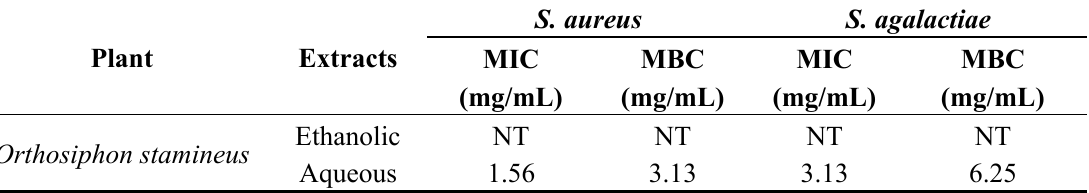
Table 2. Minimum inhibitory concentration (MIC) and Minimum Bactericidal Concentration (MBC) of the investigated extracts. Plant Extracts MIC Ethanolic Orthosiphon stamineus